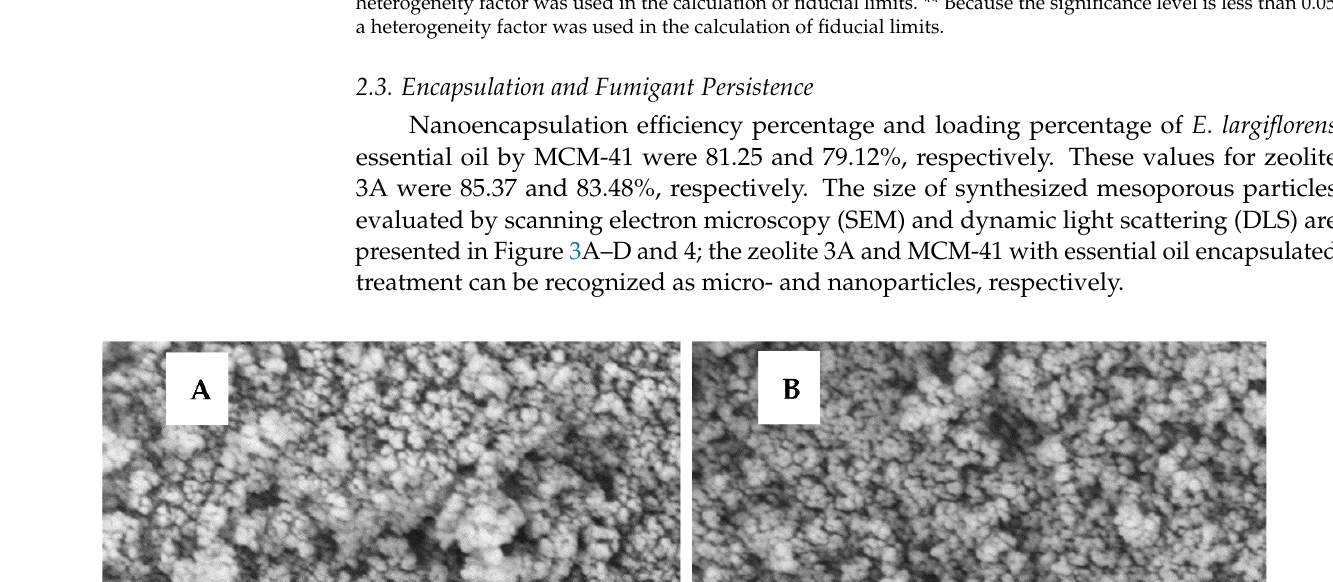
Figure 2. Mean mortality percentage (±SE) of C. maculatus adults exposed to fumigation with Eu-